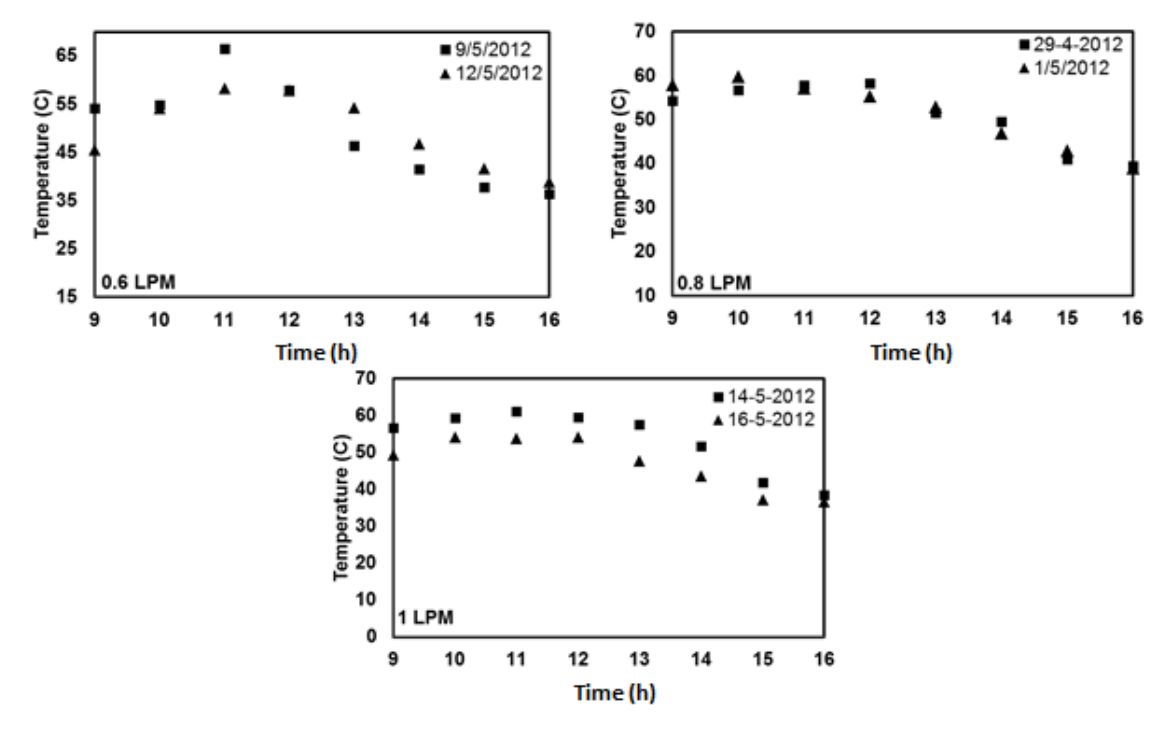
Figure 17. Front panel temperature.